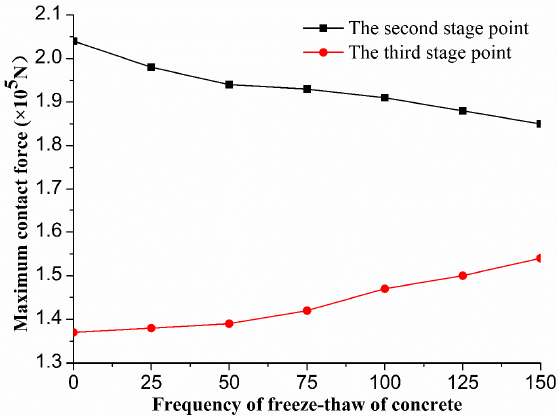
Figure 10. Maximum contact force of freezing–thawing-damage concrete.